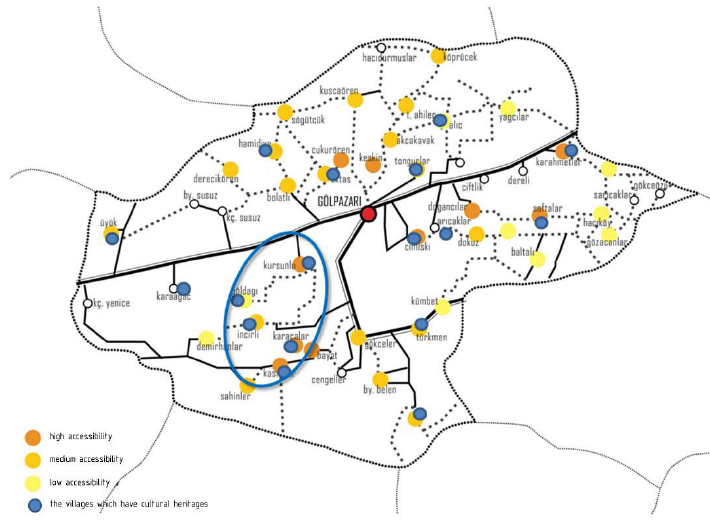
Figure 2 The villages of Gölpazarı (illustration arranged by Keep Your Village Alive Project, Past to Future Exhibition, 2015.)